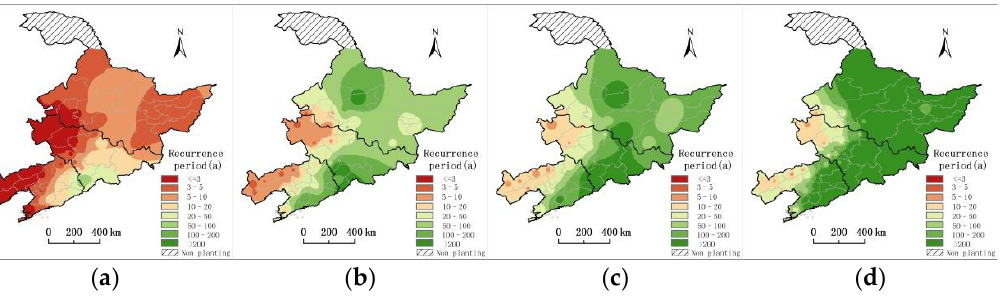
Figure 11. Spatial distribution of the co-occurrence-recurrence periods for agricultural drought events of different severity in Northeast China from 1981 to 2020. ( a )Light drought; ( b ) moderate drought; ( c ) severe drought; ( d ) extreme drought).